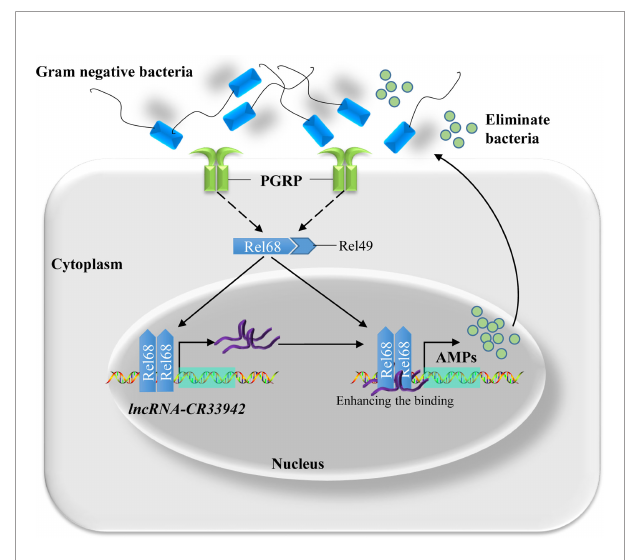
FIGURE 7 | Schematic diagram of Relish-mediated lncRNA-CR33942 enhancing Drosophila Imd immune response and maintaining immune homeostasis. Gram-negative bacteria activated the Imd signaling pathway, and transcription factor Relish entered the nucleus to promote the expression of AMPs and lncRNA-CR33942 . The latter interacted with Relish and enhanced its binding to the AMP promoters, which in turn strengthen the insuf fi cient immune response and maintaining immune